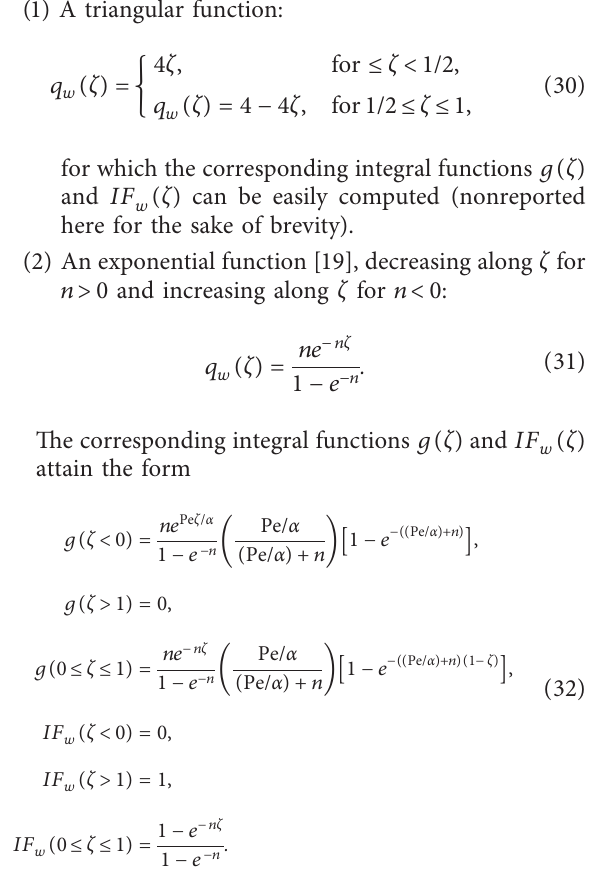
Figure 2: Color plot of the mesh element size [dimensionless units] for the computational domain (− β − ≤ ζ ≤ 1 + β + , 0 ≤ ρ ≤ 1 ) for β − � β + �